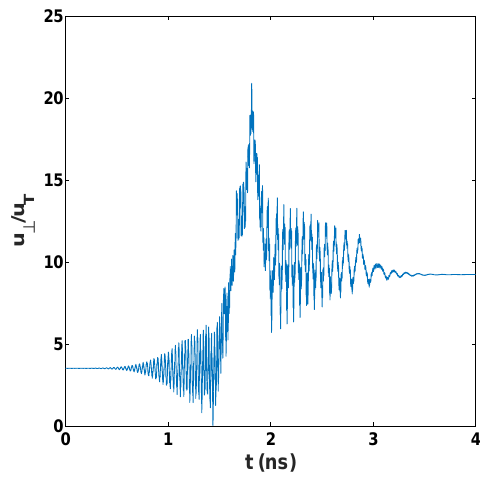
Figure 4. Same as Fig. 2 except that the beam power is 10 MW.